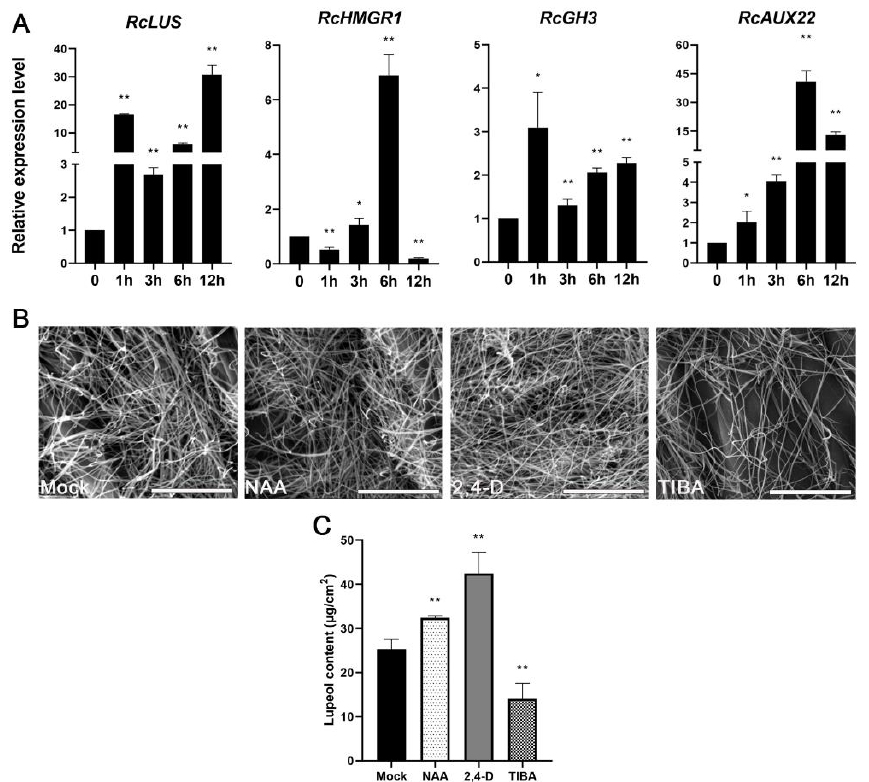
Figure 3. Lupeol levels are induced by auxin. ( A ) Relative expression levels of four different genes including RcLUS (LOC8280320), RcHMGR (LOC8258747), RcGH3 (LOC8285710), and RcAUX22 (LOC8271341) in the leaf of castor 1028 individual subjected to mock, 30 μM NAA for 0 h, 1 h, 3 h, 6 h, and 12 h. ( B , C ) Wax crystals ( B ) and lupeol content ( C ) on the surface of the third leaves of castor treated with mock, 30 μM NAA, 10 μM 2,4-D, and 30 μM TIBA, respectively. Bar = 10 μm. * P < 0.05, ** P < 0.01.